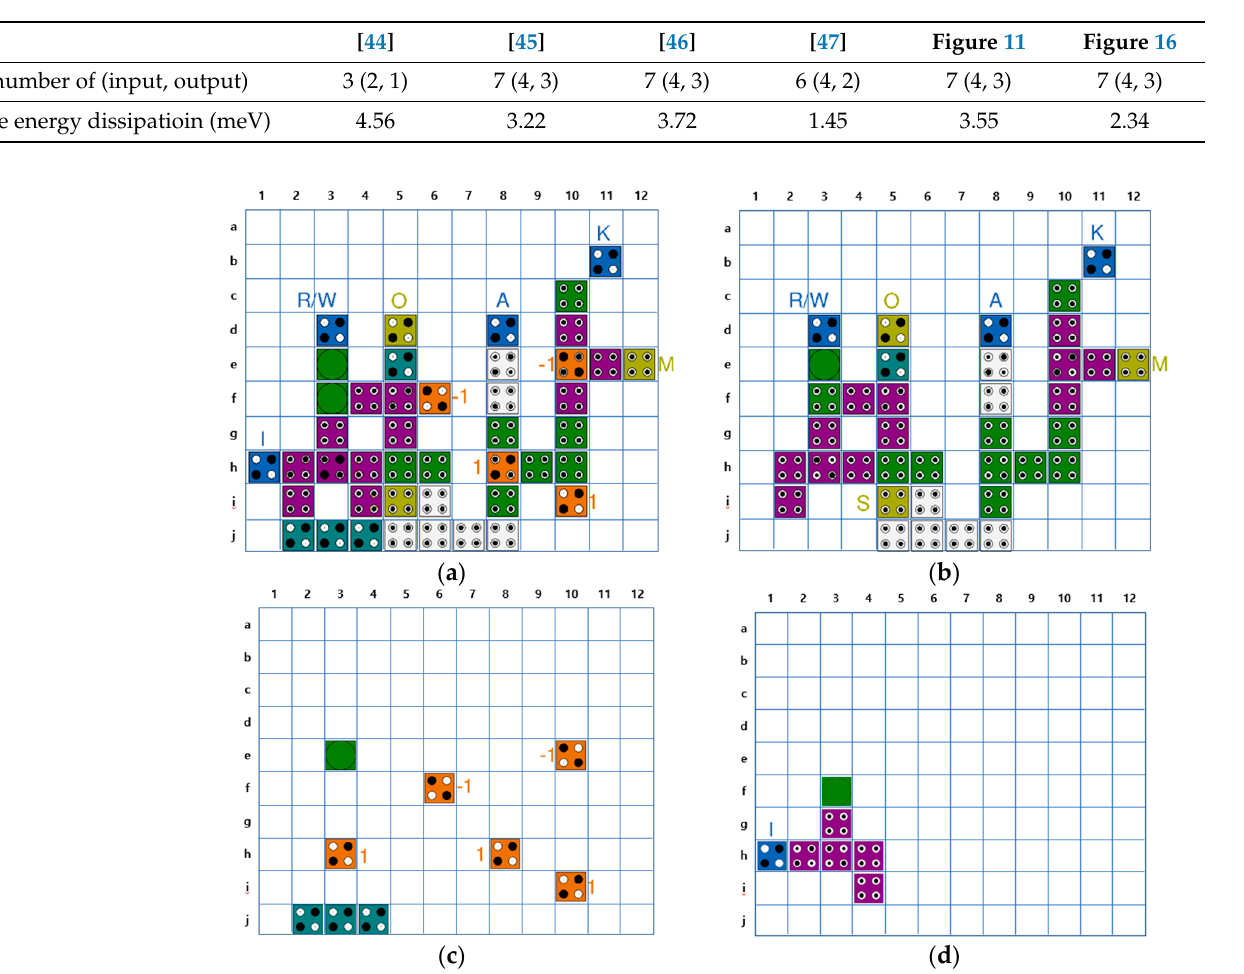
Table 7. Energy dissipation comparison of QCA CAM cells.